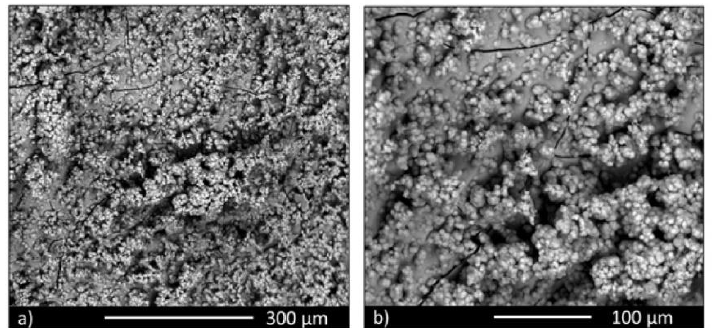
Figure 2. Simulated body fluid (SBF) tests: HA deposition on BGMS10 disks after 14 days of immersion ( a ) and higher magnification detail ( b ).